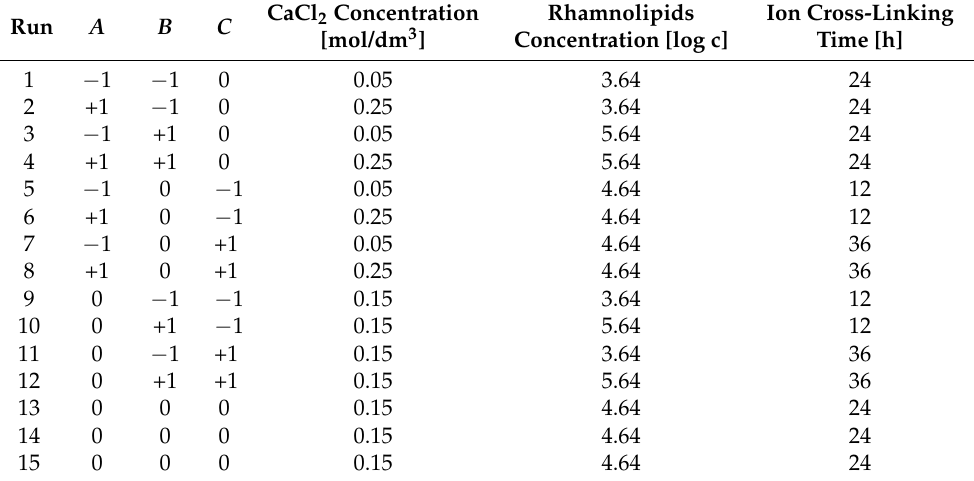
Table 2. Box-Behnken